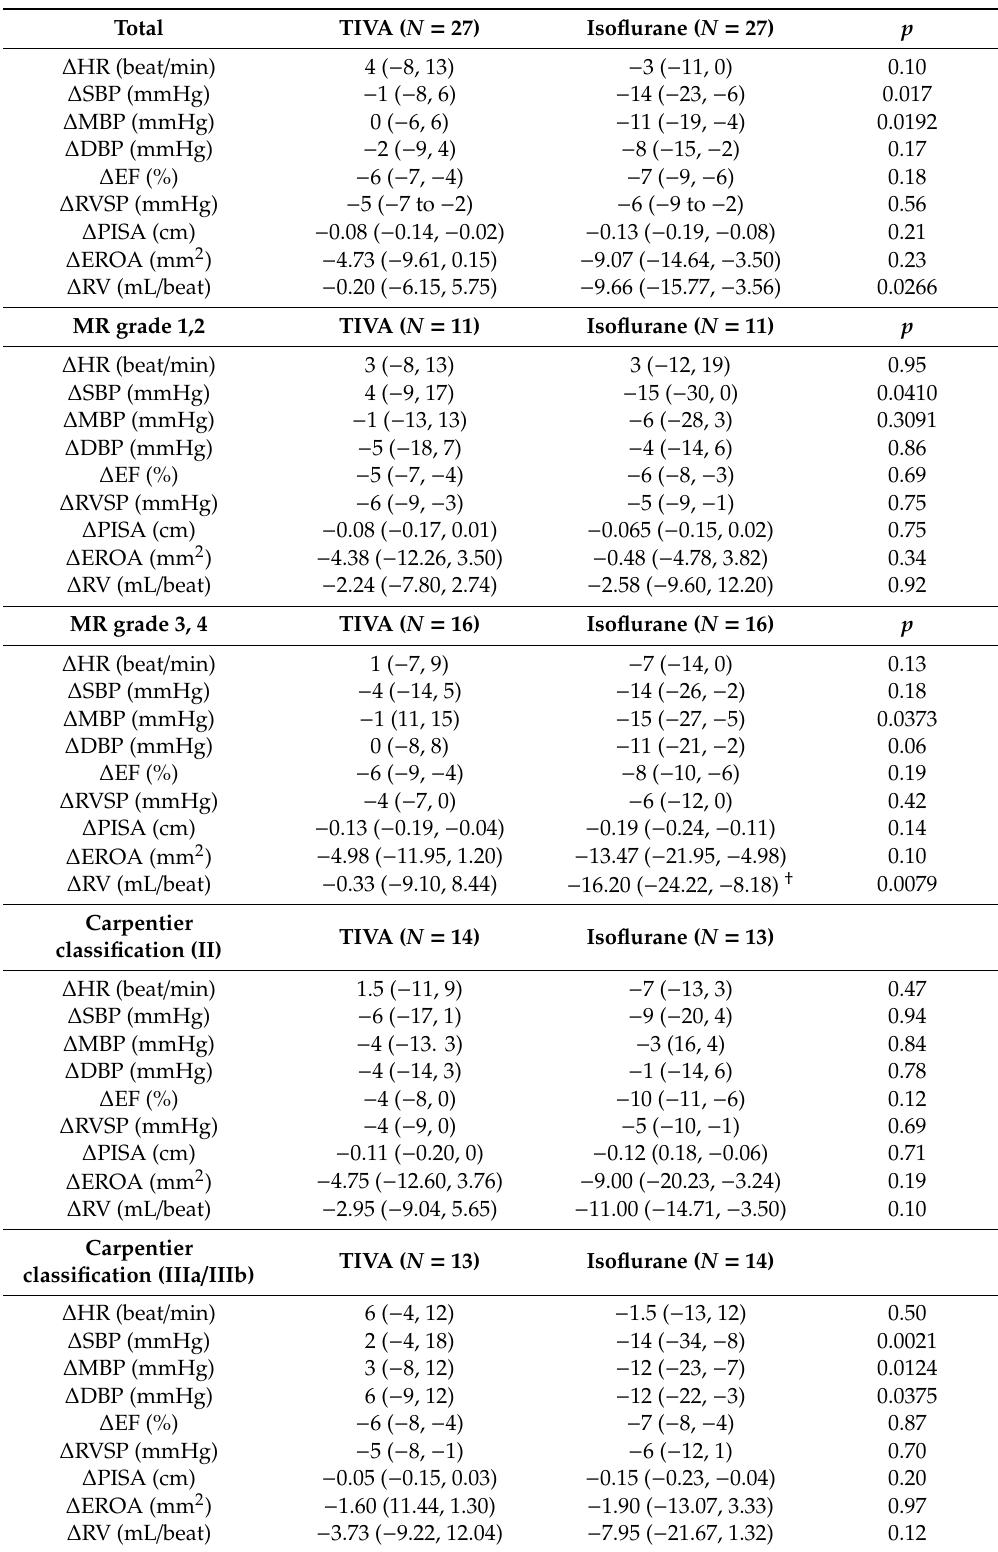
Table 3. Changes in hemodynamics according to mitral regurgitation (MR) grade and Carpentier